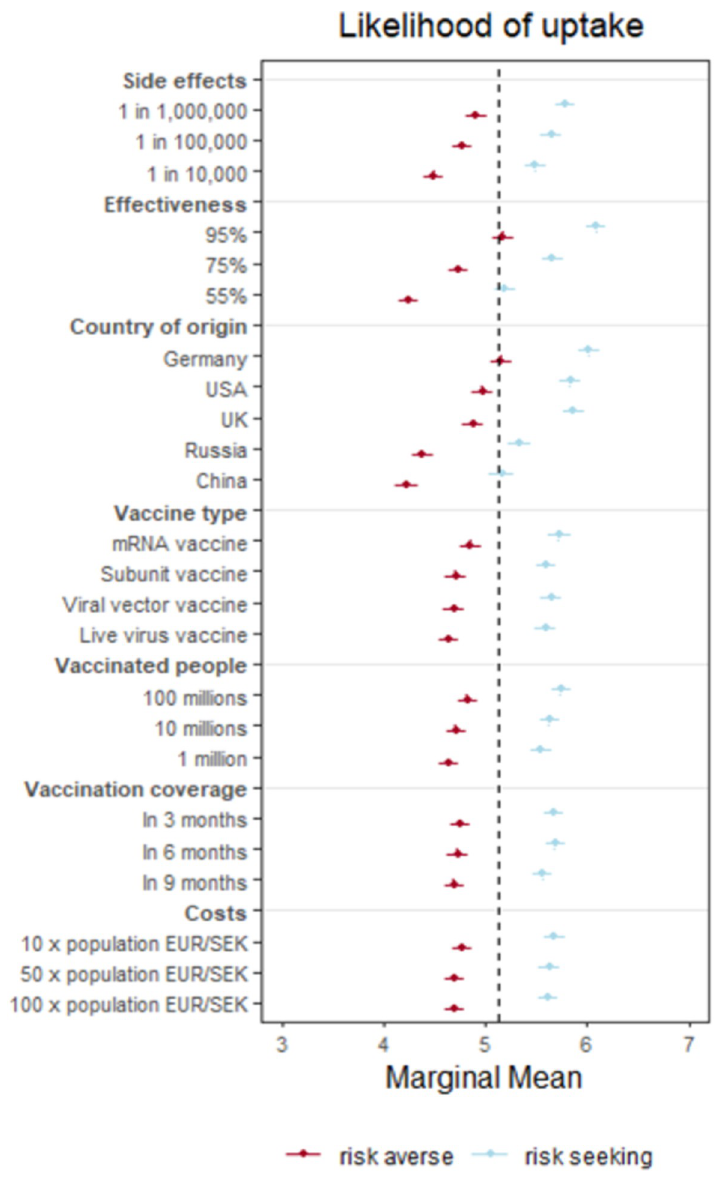
Fig 4. Subgroup analysis: Differences across different risk preference groups. Each dot and error bar represents the MM (and its 95% CI) of vaccine attributes on self-reported likelihood of uptake for the two groups of people with varying risk preferences. The dashed line represents the grand